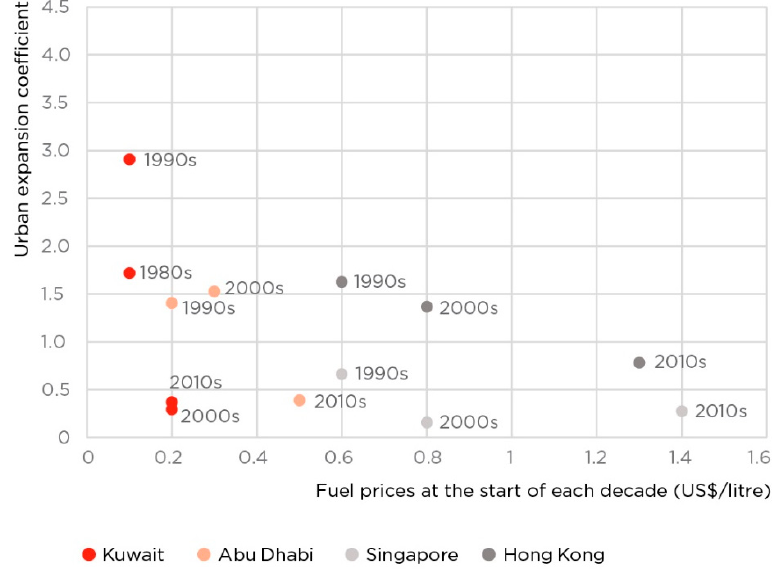
Figure 4. Fuel prices and urban expansion by decade.